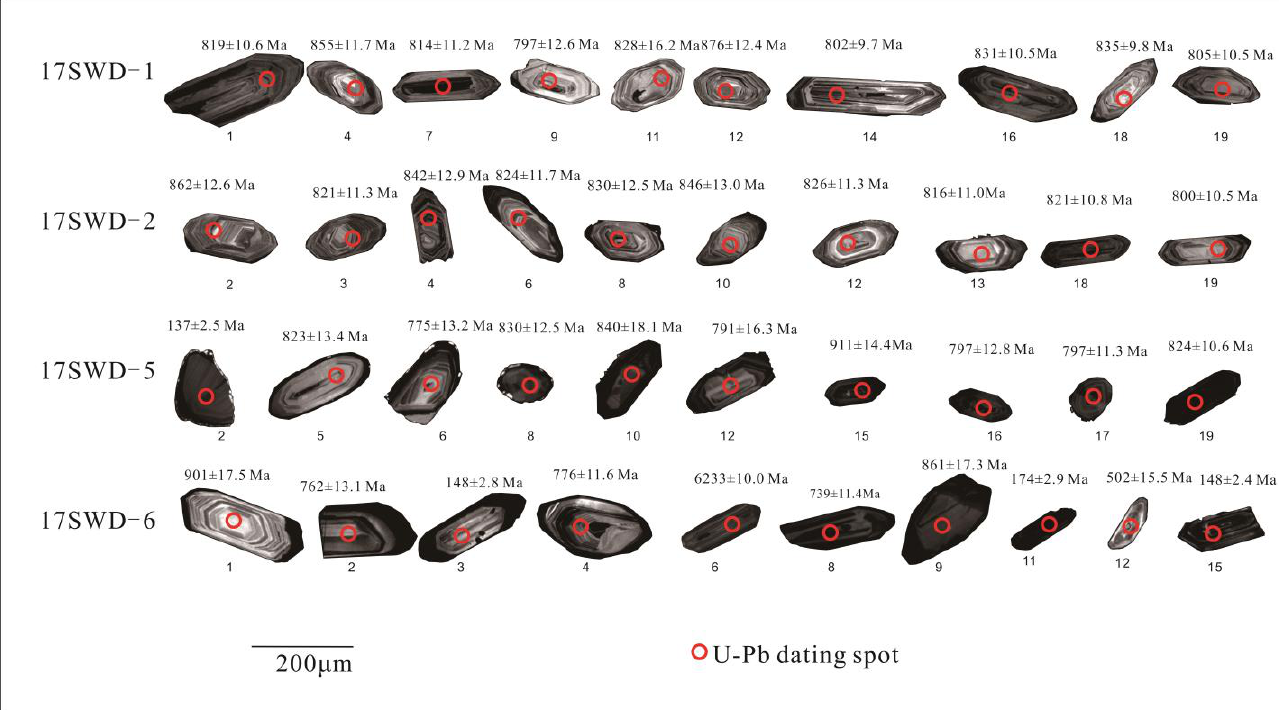
Figure 6. Th, U content and Th/U ratio of different zircon samples in the Dahutang deposit. The zircons in the Jiningian granodiorite have a total rare earth element content of 339.56 to 4415.60 ppm, with an average of 1863.61 ppm. ΣLREE ranges from 2.46 ppm to 2205.42 ppm, and ΣHREE ranges from 337.10 to 3719.67 ppm, which is characterized by an enrichment of heavy rare earths with the exception of some samples with a high con- tent of light rare earths. In addition, our zircon samples have moderate to strong negative Eu anomalies (Eu* = 0.01 – 0.57) and intense positive Ce anomalies (Ce* = 0.99 – 97.72). De- tailed zircon trace elements data are shown in Supplementary Table S4.